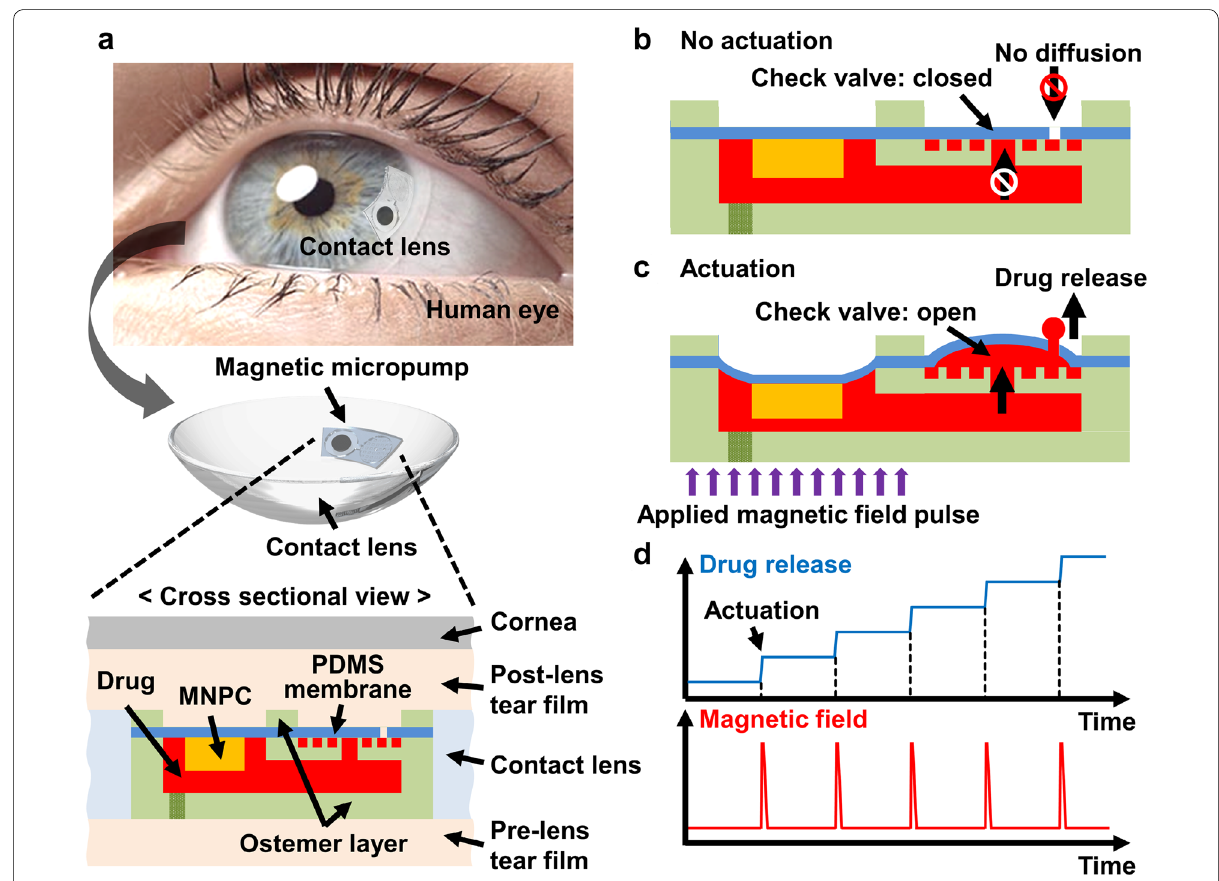
Fig. 1 a Schematic illustration of the proposed thin magnetic micropump integrated in contact lens. In the cross-sectional view, it shows the drug can be released from the micropump into the post-lens tear film through the aperture in the PDMS membrane. b – c The working principle of the proposed micropump: the status of the micropump under no actuation and actuation of magnetic field pulse, respectively. d The resulting on-demand drug release under an external controllable magnetic field